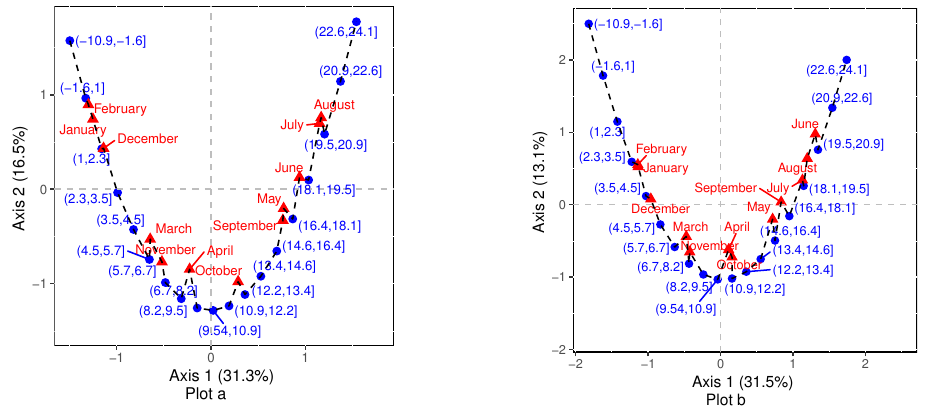
Figure 3. DOCA polynomial biplot. Temperature and month association in Lombardy. Plot a refers to the year 1986 and plot b to the year 2015.